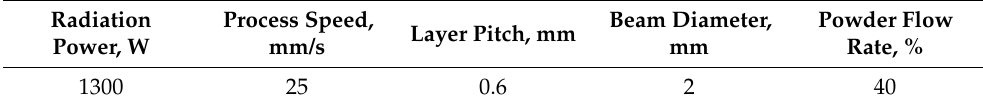
Table 1. Parameters of the direct laser deposition facility